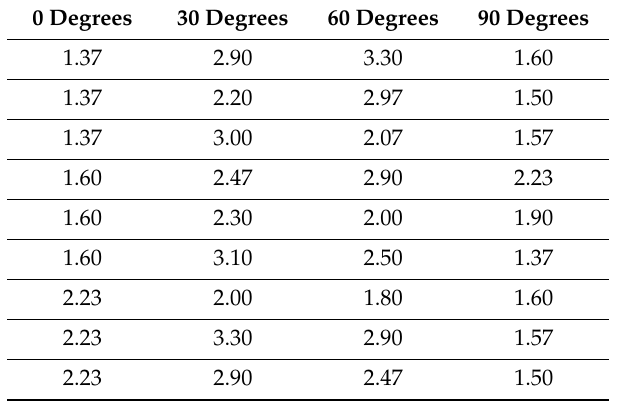
Table 29. DOE setup for Ra as a function of angular orientations.